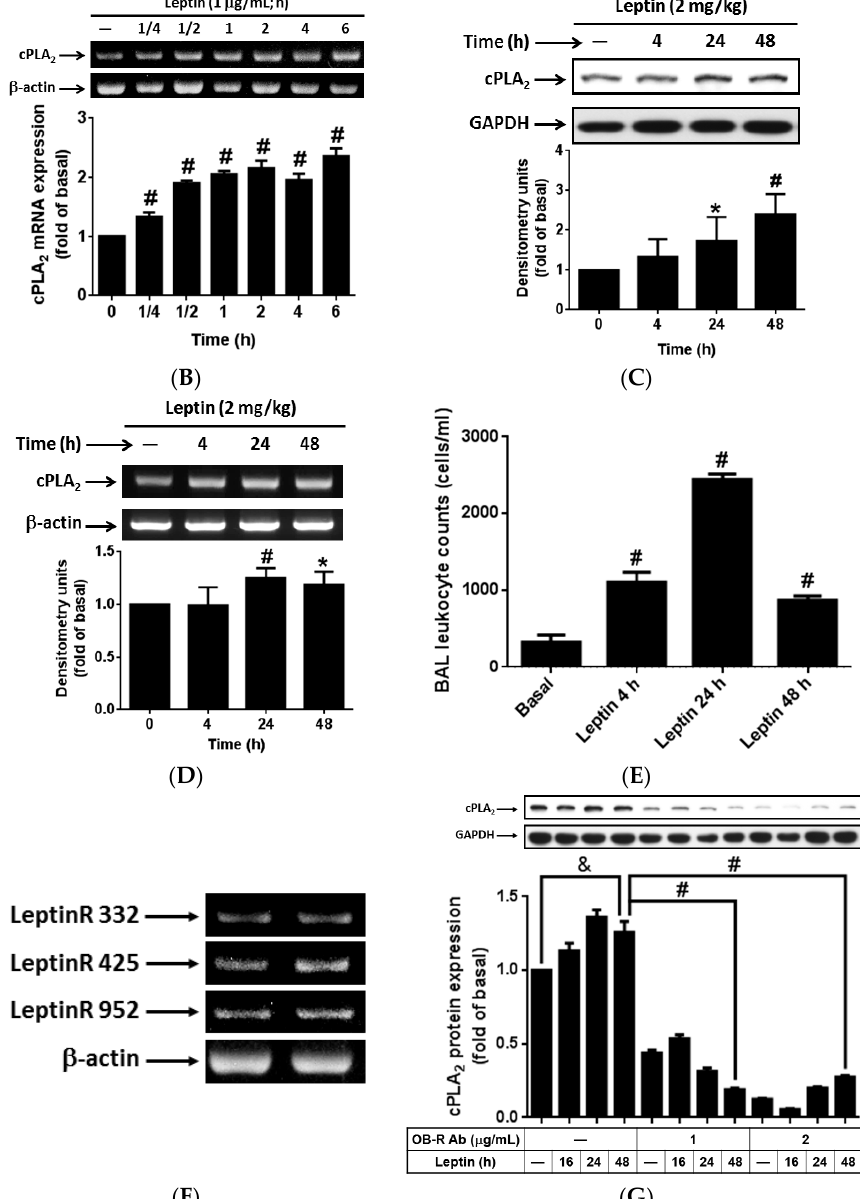
Figure 1. Leptin-stimulated gene expression of cPLA 2 - α . ( A , B ) A549 cells were incubated with various concentrations or 1 µg/mL of leptin for the indicated time intervals. Expression of cPLA 2 - α was determined using ( A ) Western blot and ( B ) RT-PCR; ( C – E ) The ICR mice were treated with leptin (2 mg/kg) for the indicated time points. After the mice were sacrificed, lung tissues and bronchoalveolar lavage (BAL) fluid were extracted as described in the Experimental section; ( C ) Western blot was used to determine the protein expression; ( D ) RT-PCR was used to determine the mRNA expression and ( E ) leukocytes in BAL fluid were counted using a hematology analyzer. Data are expressed as mean ± SEM of 5 independent experiments ( n = 5). # p < 0.01 or * p < 0.05 as compared with the cells exposed to the vehicle alone; ( F ) Expression of leptin receptor isotypes were examined using RT-PCR; ( G ) A549 cells were pretreated with 1 or 2 µg/mL of the OB-R antibody for 1 h and then incubated with 1 µg/mL of leptin for the indicated time intervals. The expression of cPLA 2 - α protein was determined using Western blot. The data are expressed as mean ± SEM of five independent experiments ( n = 5). & p < 0.05 as compared with the cells exposed to vehicle alone; # p < 0.01 as compared with the cells exposed to leptin.